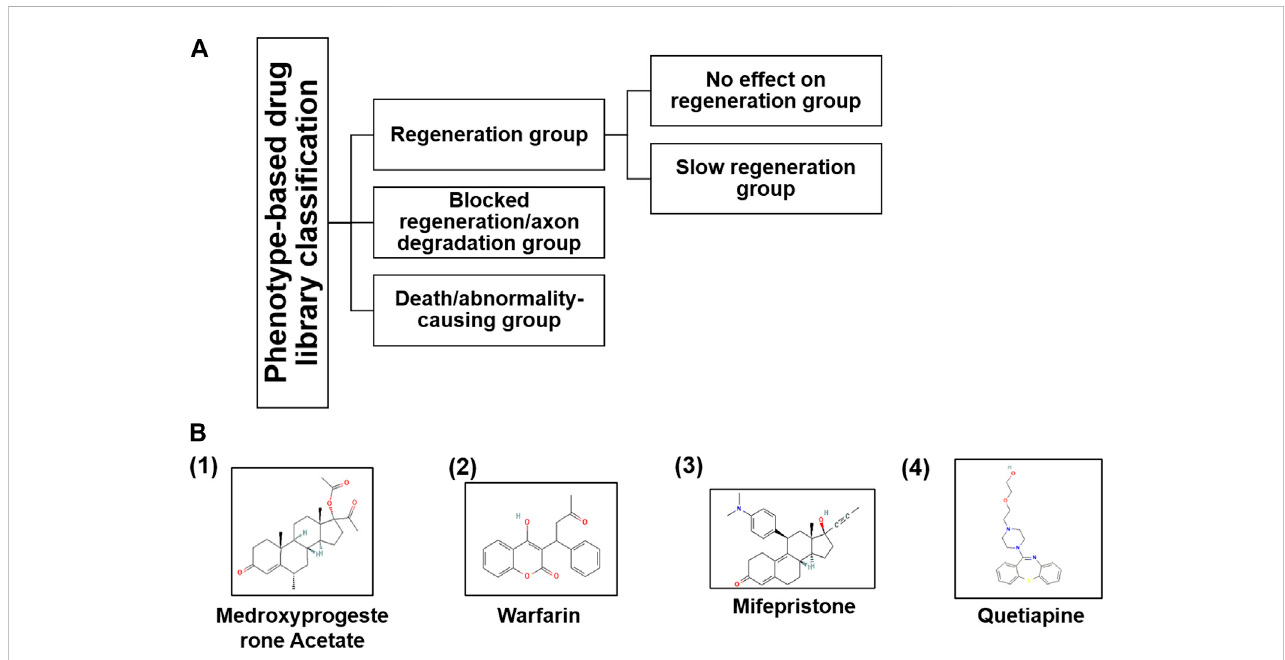
FIGURE 3 (A) Based on the phenotypic responses of M-cells upon drug treatment, we classi fi ed the entire library into three categories along with sub-categories and (B) their chemical structures taken from PubChem (nih.gov)